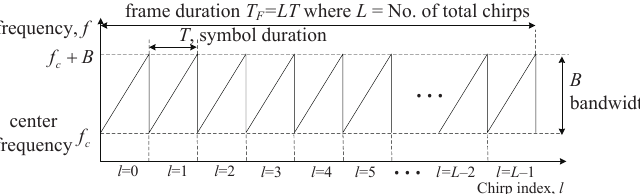
Figure 1. Structure of the transmit (TX) signal of FMCW radar where f is frequency, B is bandwidth, L is the number of chirps per one frame, T is symbol duration, f c is center frequency, and T F is frame